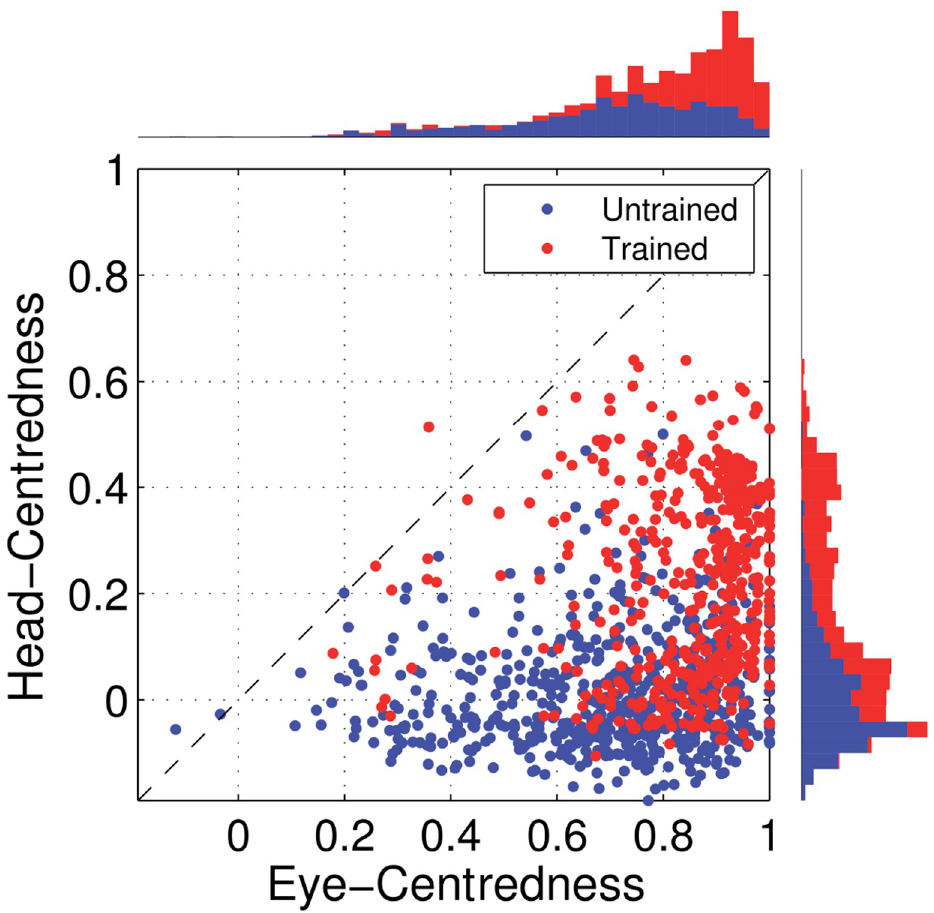
Fig 23. Simulation results showing the output reference frame response characteristics of a model incorporating a population of sigmoidal modulated input neurons trained with the modified learning rule 20: Delayed postsynaptic trace learning rule. The scatter plot shows the reference frame response characteristics of all output neurons before and after training. Conventions as for Fig 14. It is evident that training had the effect of increasing the head-centredness values of most output neurons. Although, there is only a single head-centred output neuron present in the trained model.